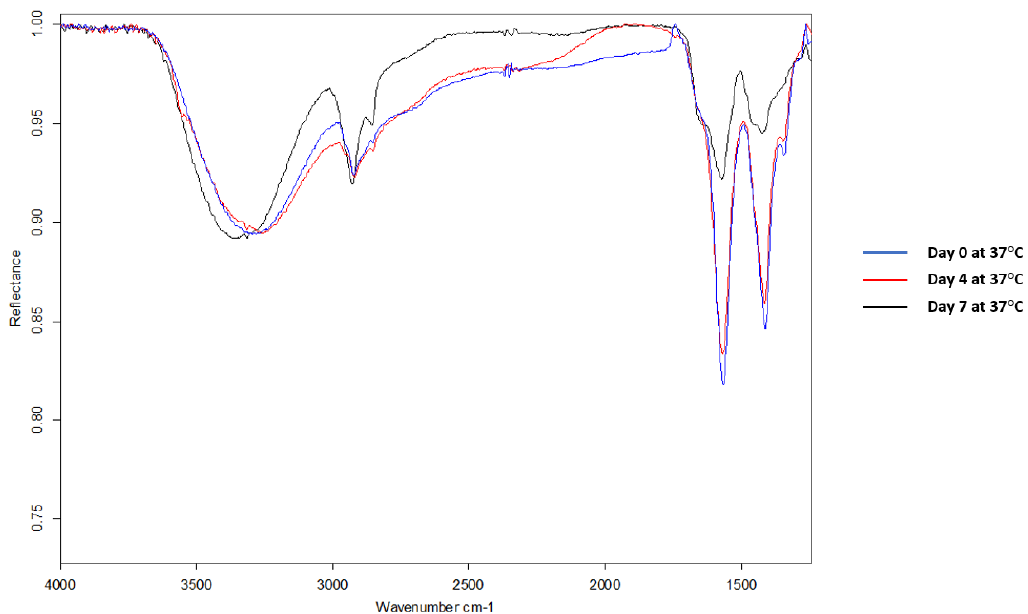
Figure 3. Mid-infrared spectra of samples, drop-casted on gold-coated coverslips were collected using Bruker Optics vertex FTIR spectrometer. FTIR spectra of CK2.3-Qdot® s depicting its stability at 37 °C over the course of day 0, day 4, and day 7. FTIR spectra’s of CK2.3-Qdot® s at day 4 and day 7 are about 94.44% and 44.44% similar to day 0 spectra;